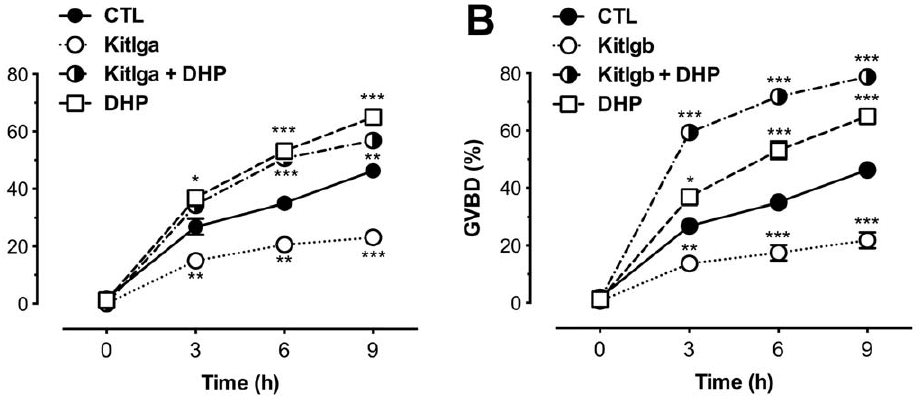
Figure 13. Effects of recombinant zebrafish Kitlga and Kitlgb on oocyte maturation. Full-grown immature follicles were pretreated for 6 h with Kitlga (200 m l Kitlga conditioned medium + 200 m l control medium per ml), Kitlgb (400 m l/ml Kitlgb conditioned medium) and control medium (CTL, 400 m l per ml)), respectively, followed by treatment with DHP (5 ng/ml) for 9 h. Germinal vesicle breakdown (GVBD) was scored at different time points and expressed as the percentage (mean 6 SEM, n=4).